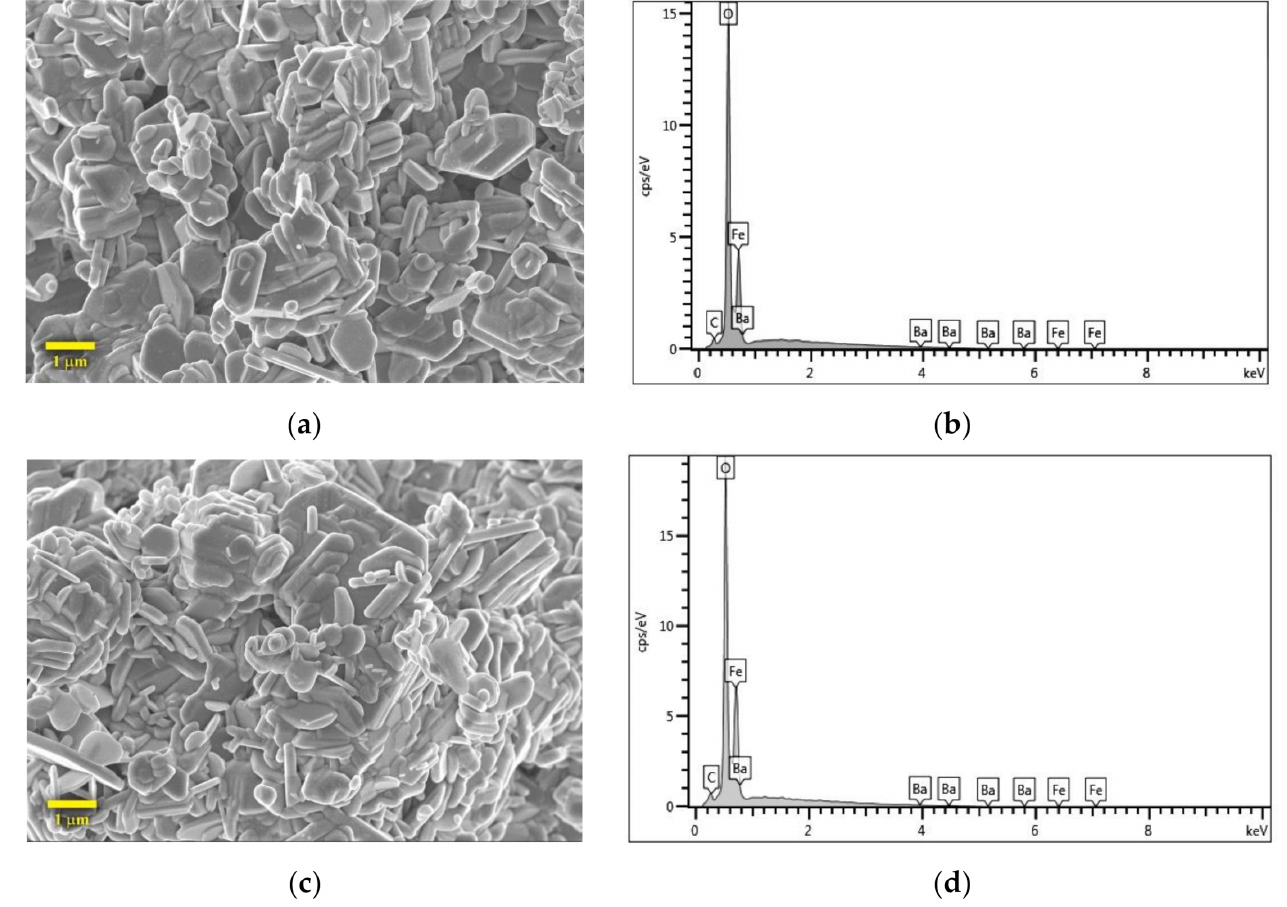
Figure 2. Morphology and elemental composition of sol-gel derived products after the calcination; ( a ) FESEM image and ( b ) EDS spectra of BaM_ex1; ( c ) FESEM image and ( d ) EDS spectra BaM_ex2. Table 1. Coercivity ( H c ), remanent magnetization ( M r ), and maximum energy product (( BH ) max ) of BaM powders, pressed BaM pellet, and BaM-ABS